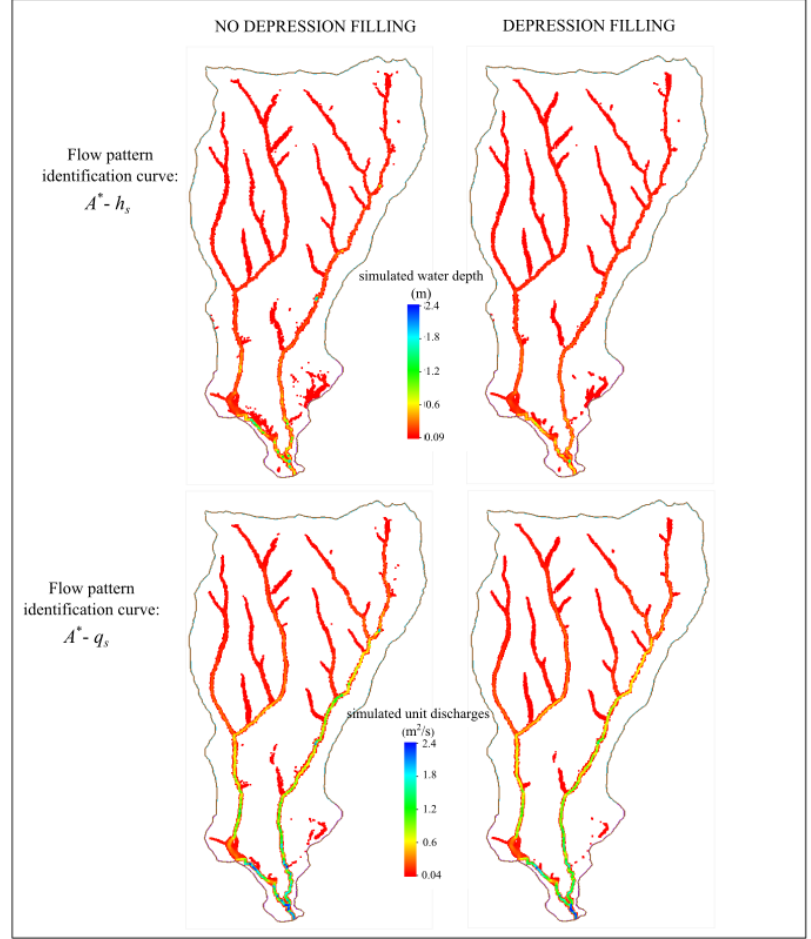
Figure 5. Luvinate watersed: effects of the DEM filling on the river drainage patterns tracked by the rain ‐ on ‐ grid approach using the bimodal scaling laws criteria.